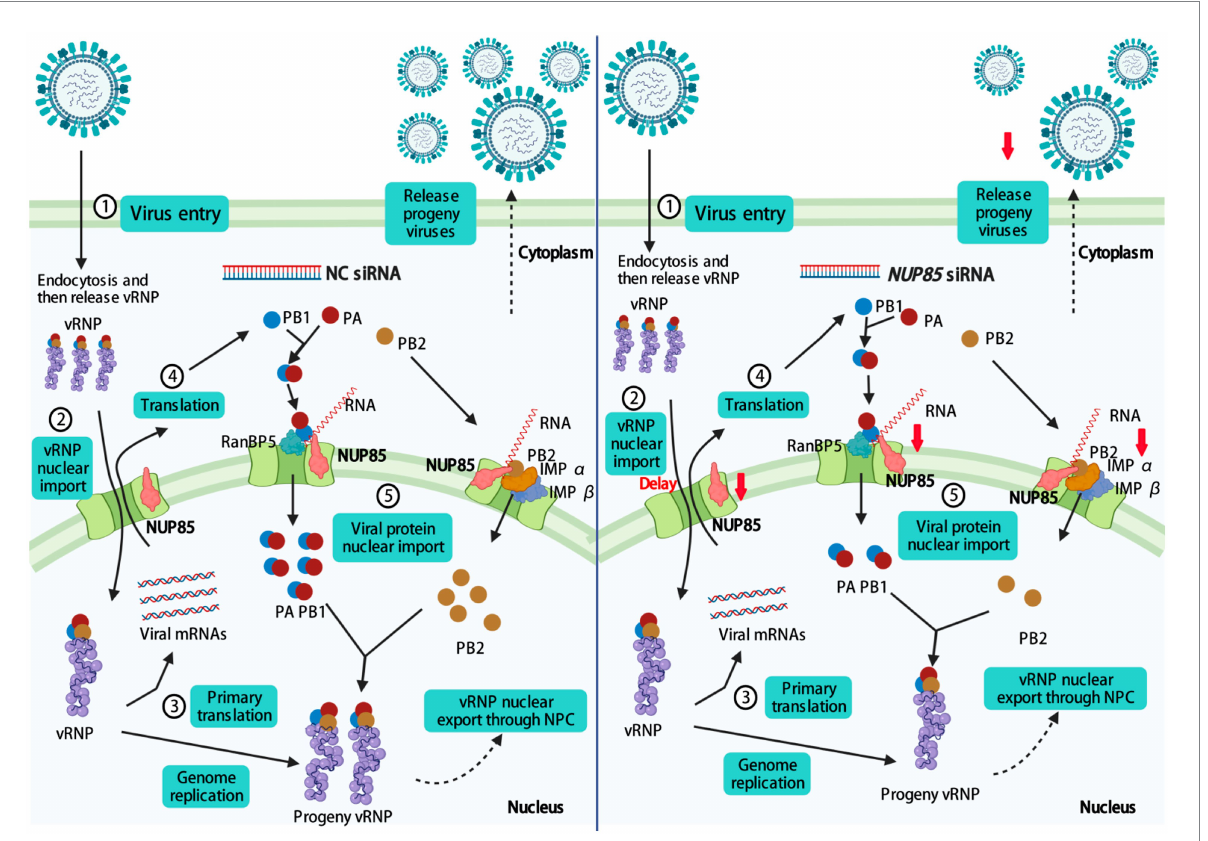
FIGURE 8 Proposed model for NUP85 facilitating nuclear import of vRNP and therefore promoting viral replication. Knockdown of NUP85 delays the nuclear import of vRNP, PB1, and PB2, which finally hinders viral replication. The figure was drawn at biorender.com under the agreement number of